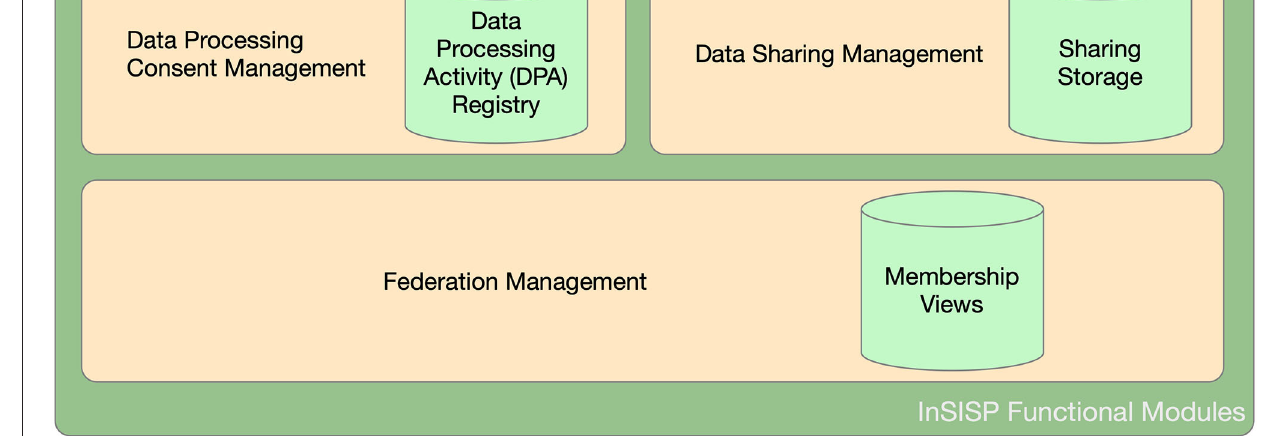
FIGURE 5 | InSISP functional decomposition.